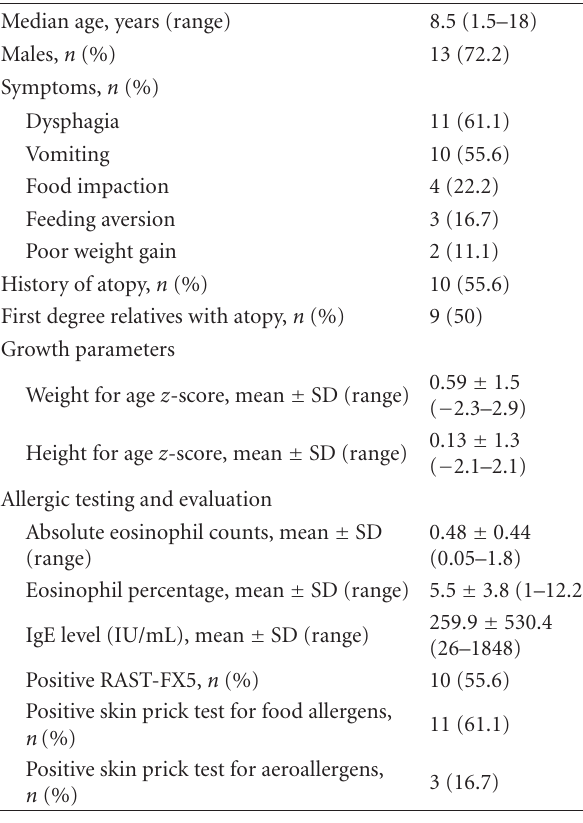
Table 2: Endoscopic and histopathological characteristics of chil- dren with